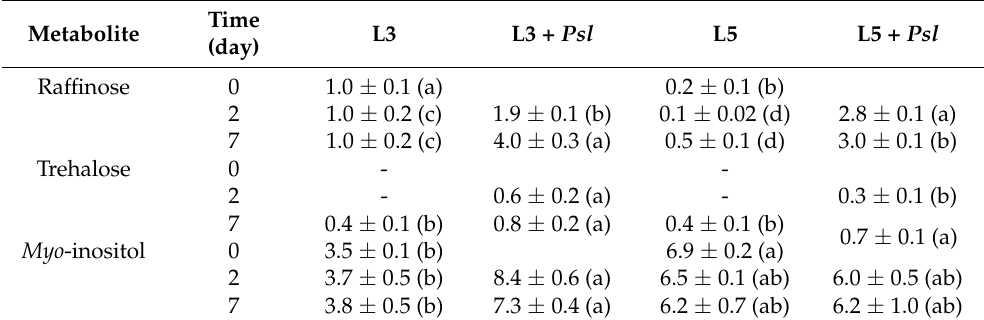
Table 2. Infection-induced changes in relative metabolite contents in cucumber leaves after Pseudomonas syringae pv lachrymans infection.